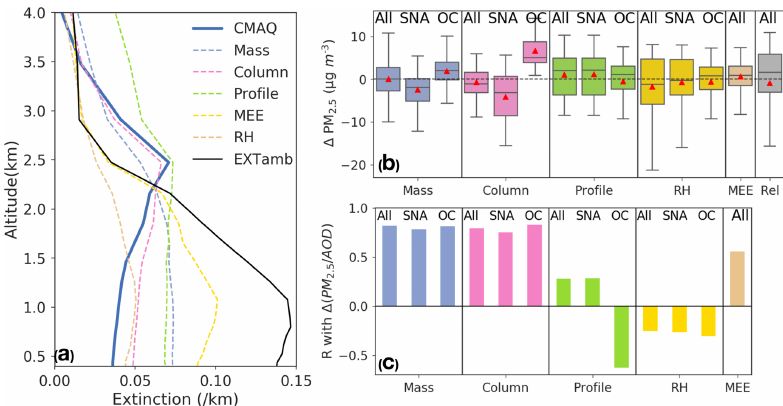
Figure 8. (a) Campaign-mean vertical profiles of extinction calculated from CMAQ speciated aerosol fields using FlexAOD and those calculated by replacing modeled speciated aerosol mass (Mass), total column mass (Column), vertical profile shape (Profile), total mass extinction efficiency (MEE), and relative humidity (RH) with those observed during the DISCOVER-AQ 2011 Baltimore–Washington, D.C. campaign. EXT amb is the aircraft observed vertical extinction profile. (b) Box plots of the distribution of biases of PM 2 . 5_MAIAC attributed to each factor shown in (a) , and the biases of PM 2 . 5_MAIAC attributed to modeled PM 2 . 5 / AOD (Rel). Red triangles show the mean biases. (c) Pearson correlation coefficient between the biases in modeled PM 2 . 5 / AOD relationships and the biases in modeled PM 2 . 5 / AOD attributed to individual factors shown in (b)